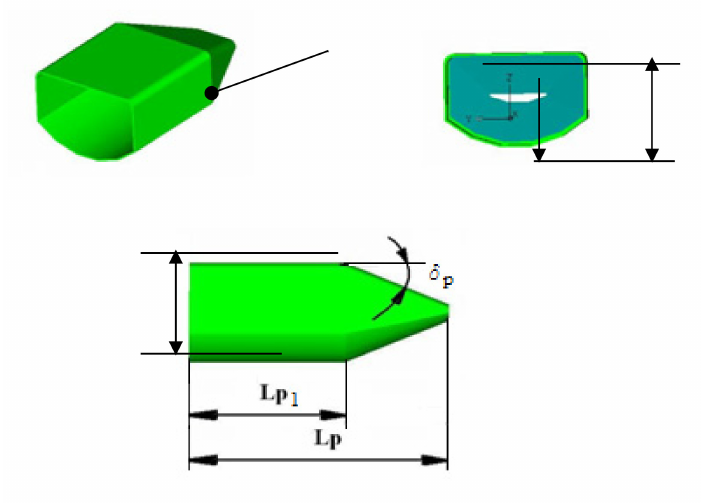
Figure 7. The rear